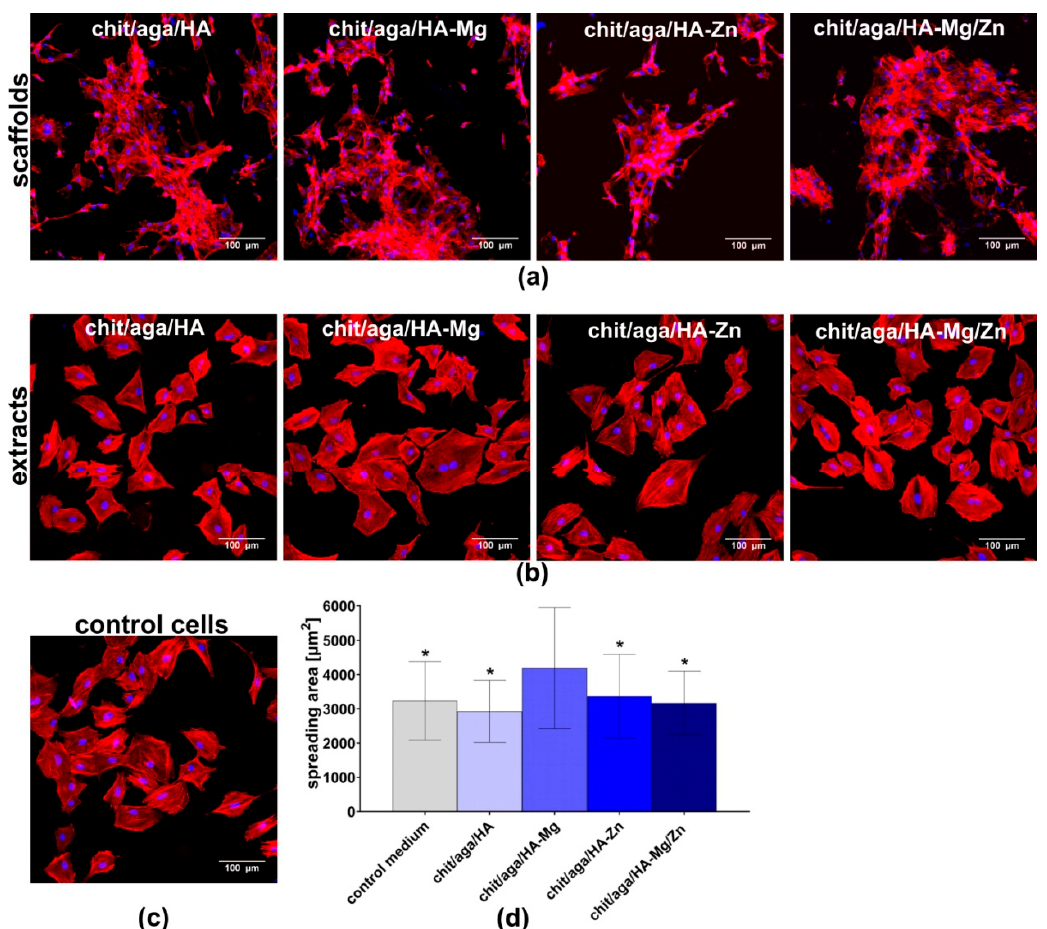
Figure 5. Evaluation of cell adhesion and spreading of MC3T3-E1 cells: ( a ) fluorescent staining of cell cytoskeleton when osteoblasts were cultured directly on the scaffolds; ( b ) fluorescent staining of cell cytoskeleton when osteoblasts were cultured in PS wells in the presence of scaffolds extracts (F-actin filaments, red fluorescence and nuclei, blue fluorescence, magnified 200×, scale bar = 100 µm); ( c ) morphology of control cells maintained in culture medium and grown in the polystyrene wells PS wells; and ( d ) quantitative evaluation of spreading area of cells cultured in the PS wells in the presence of scaffolds extracts (* statistically significant results as compared to chit/aga/HA-Mg extract, P < 0.05, one-way ANOVA followed by Tukey´s test).